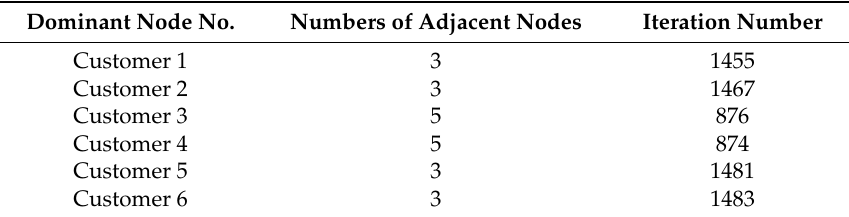
Figure 9. The total output power of customers when choosing different dominant nodes. Table 5. System response time when choosing different dominant nodes.